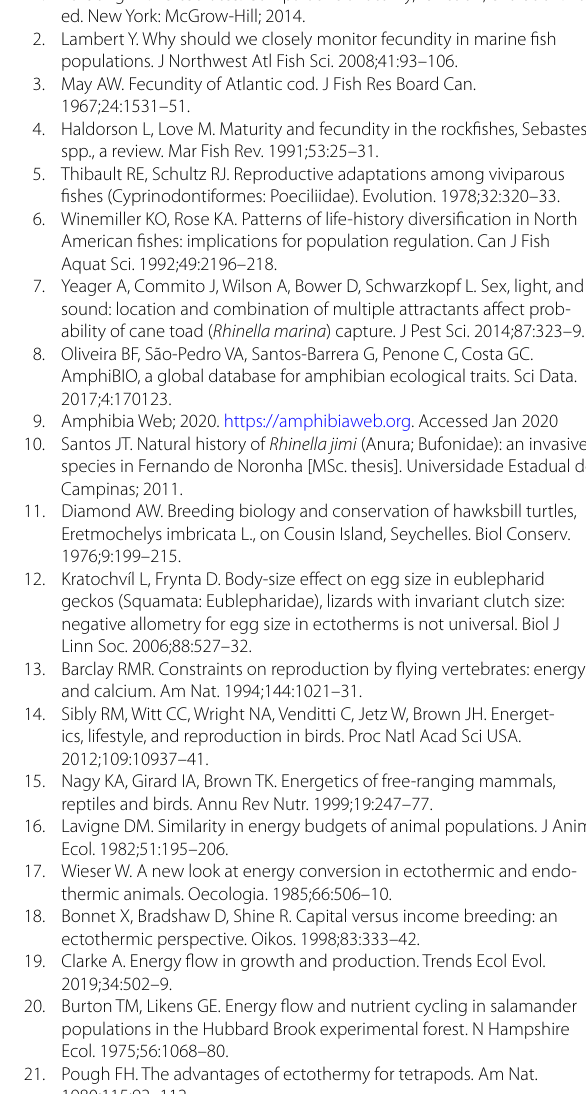
Additional file 2: Figure S1. Reproductive characteristics of birds, squa- mates, turtles, placentals, marsupials and